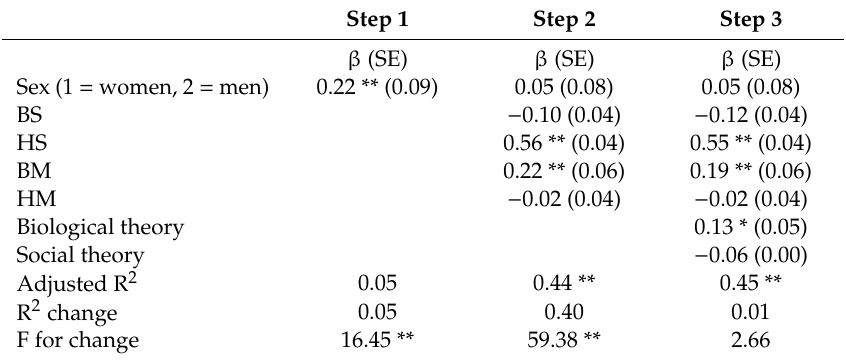
Table 3. Hierarchical regression analysis predicting domestic violence myth